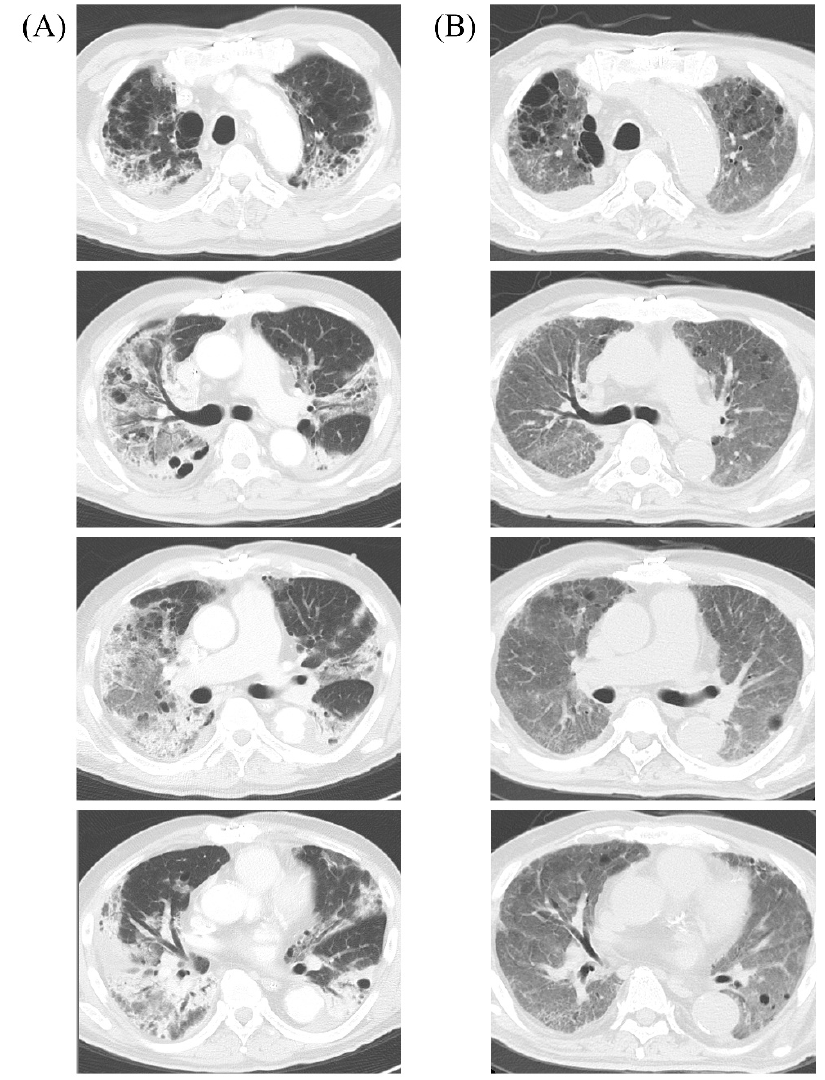
Figure 2. Chest computed tomography (CT) images of the present case: ( A ) CT on day 18 of admission (just before extracorporeal membrane oxygenation cannulation). Bilateral, peripheral, and basal predominant ground-glass opacities (GGOs) and consolidation were observed; ( B ) CT on day 228 (135 days post-decannulation). The CT shows significant improvement of GGOs and consolidation but persistent interstitial changes distributed throughout the entire lung fields. Table 1. Antimicrobial susceptibility testing in detected bacterial isolates in the present case. MIC Value (µg/mL) and Interpretation